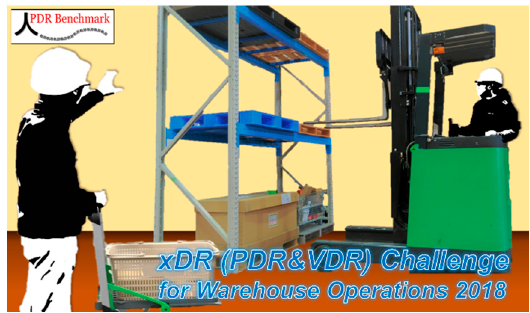
Figure 11. Teaser image of the xDR Challenge that were used for the call for participation.